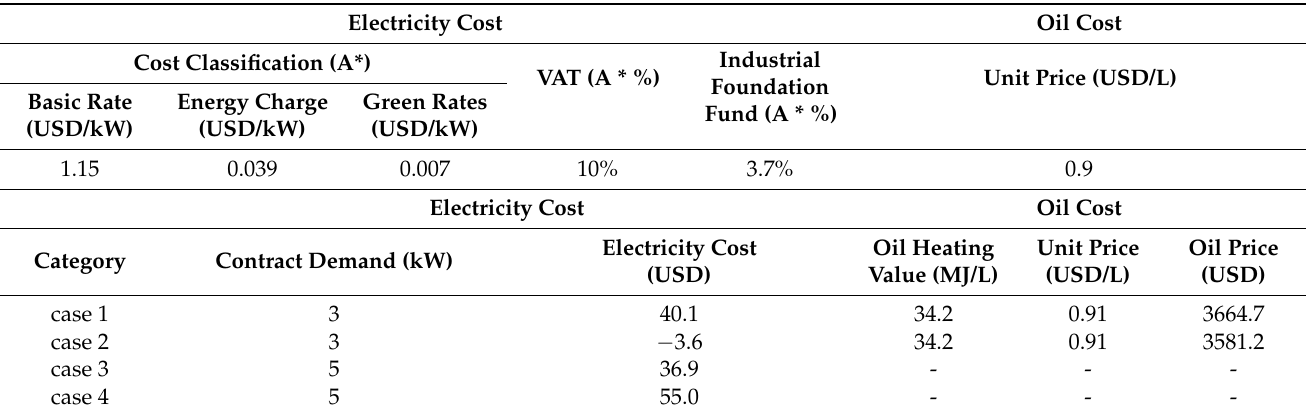
Table 5. Case-wise annual costs for each energy